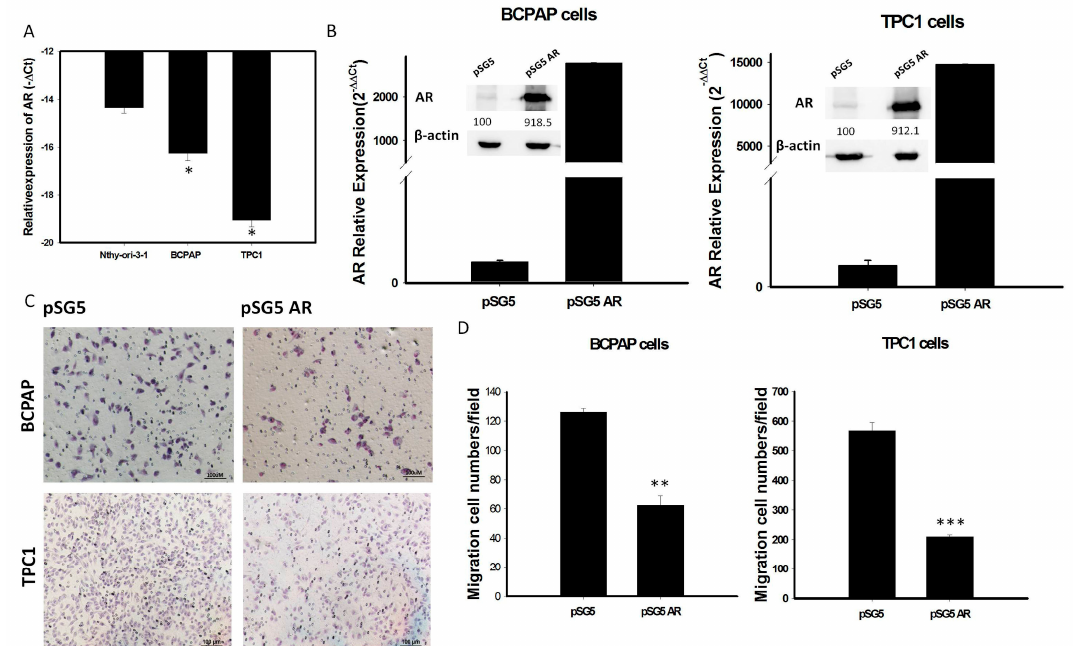
Figure 4. ( A ): The endogenous mRNA expression of AR in normal thyroid cell line (Nthy-ori-3-1) is higher than PTC-derived cancer cell lines (BCPAP and TPC1); ( B ) Quantification of mRNA and protein expression levels of AR after transfection with pSG5-AR and pSG5 in BCPAP cells and TPC-1 detected by qRT-PCR and Western blotting. The relative expression level of AR mRNA is presented as 2 −ΔΔ Ct (AR-18S) . ( C ) Reprensentative image of the cell migratory abilities of BCPAP cells and TPC-1 transfected with pSG5-AR and pSG5 in the Transwell (Corning) migration assay. ( D ) Quantitative analysis of the migratory abilities of BCPAP and TPC-1 cells transfected with pSG5-AR and pSG5. Data are presented as the means of three independent experiments, and bars represent the SDs. * p < 0.05, ** p < 0.01, *** p < 0.01